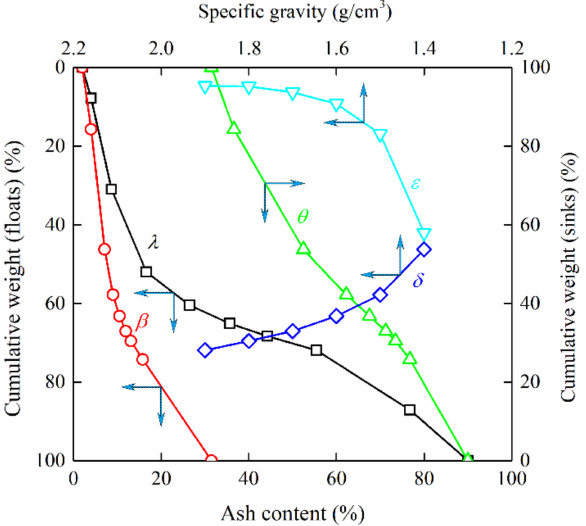
Figure 5. Classical washability curves for >0.5 mm coal. λ —primary curve; β —cumulative float curve; θ —cumulative sink curve; δ —density distribution curve; ε —near-gravity material with ± 0.1 g/cm 3 specific gravity (s.